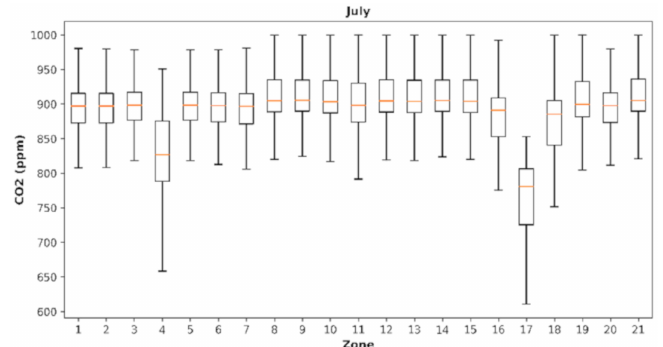
Figure A7. CO 2 concentrations in April.